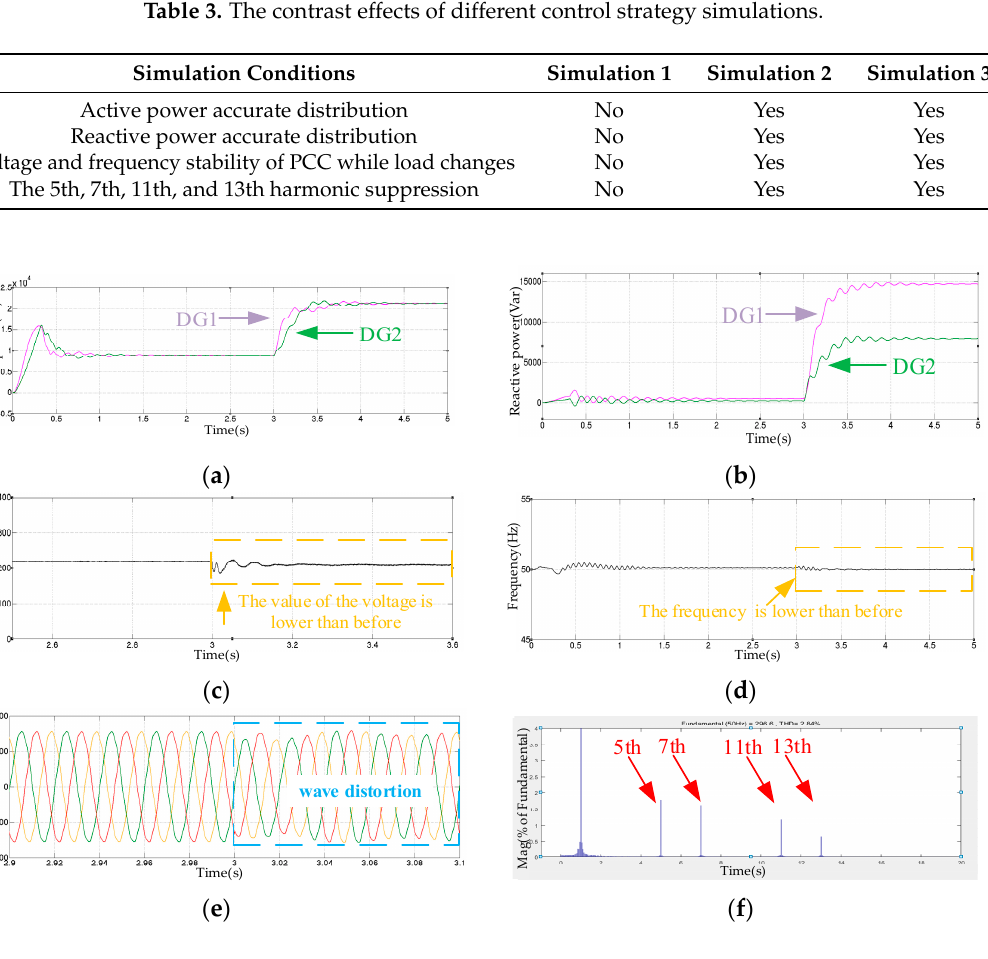
Figure 11. ( a ) Active power of DG1 and DG2 Inverters; ( b ) Reactive power of DG1 and DG2 Inverters; ( c ) The voltage value of PCC; ( d ) The frequency value of PCC; ( e ) Voltage waveform of PCC; ( f ) Voltage FFT analysis of PCC.